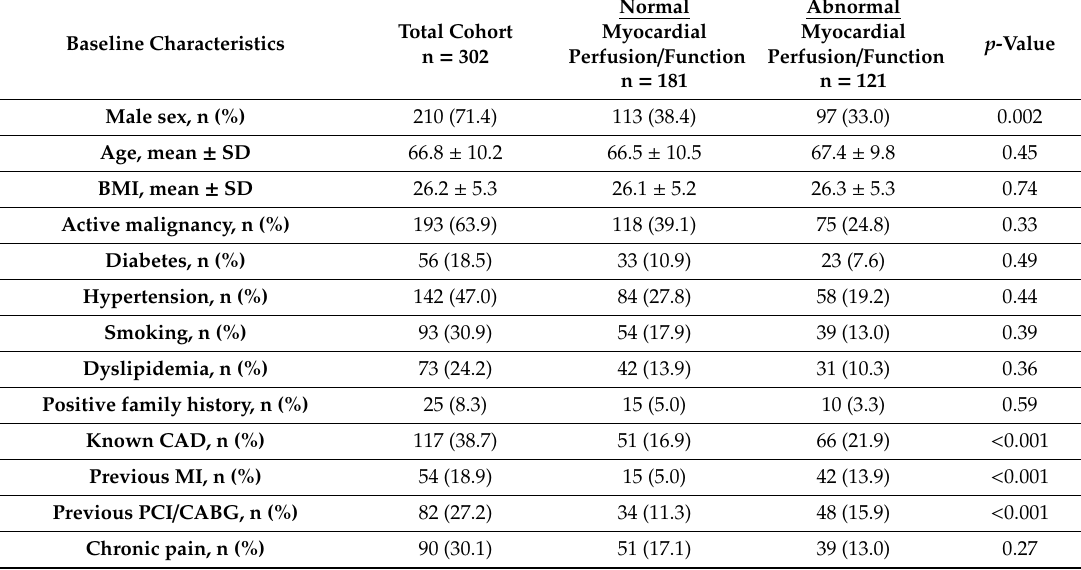
Table 2. Baseline demographics stratified by myocardial perfusion / function